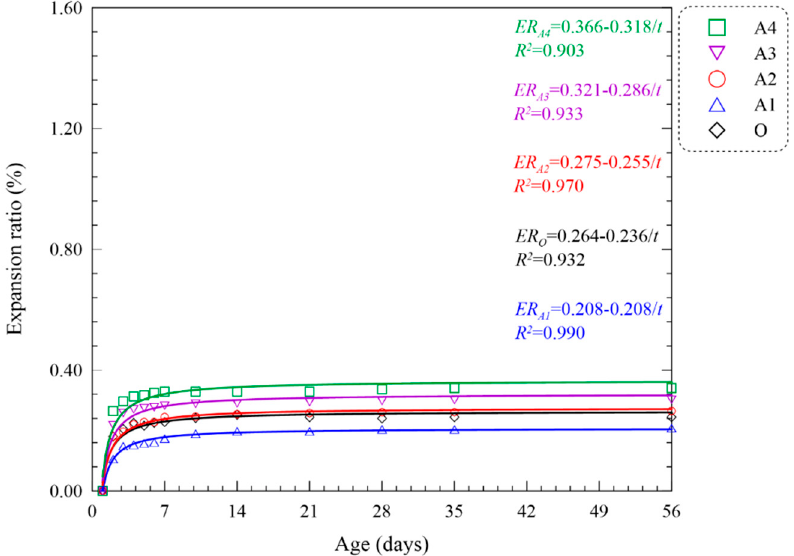
Figure 5. Fitting curve of expansion ratio of MOC pasted with